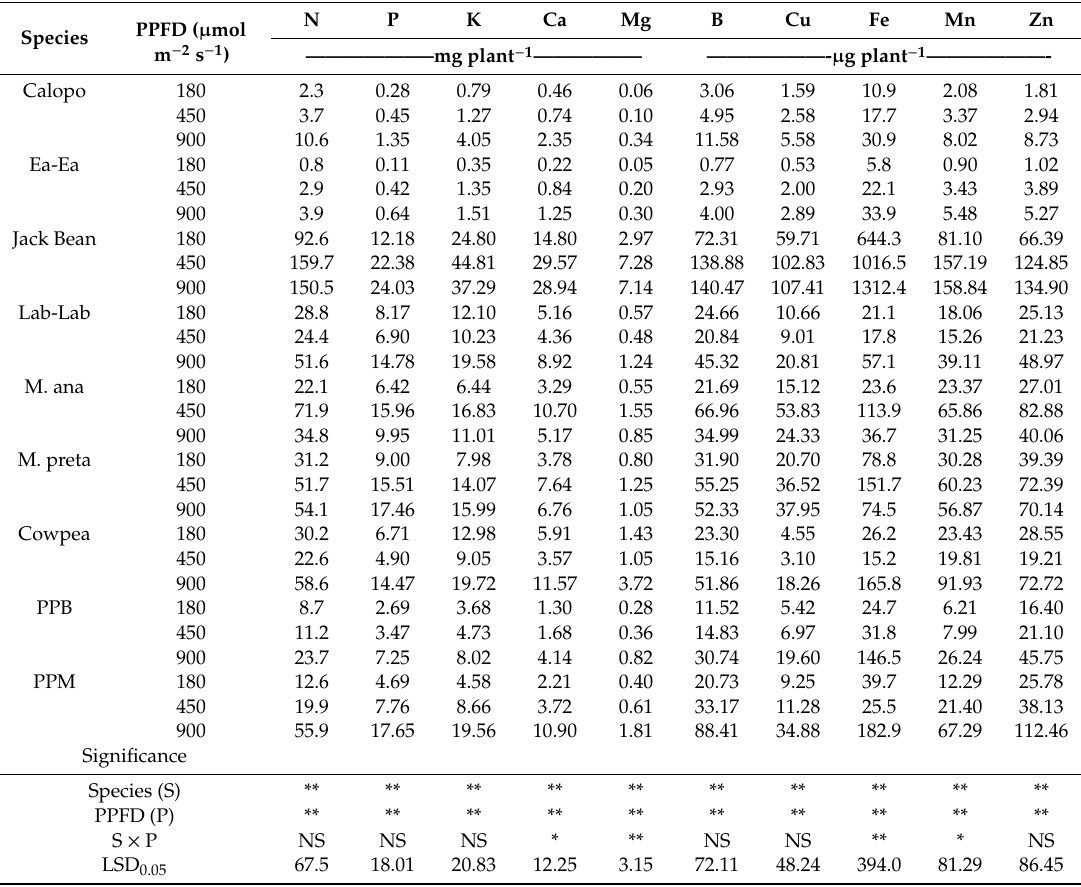
Table 6. E ff ect of photosynthetic photon flux density (PPFD) on nutrient uptake (U) in leguminous cover crops.